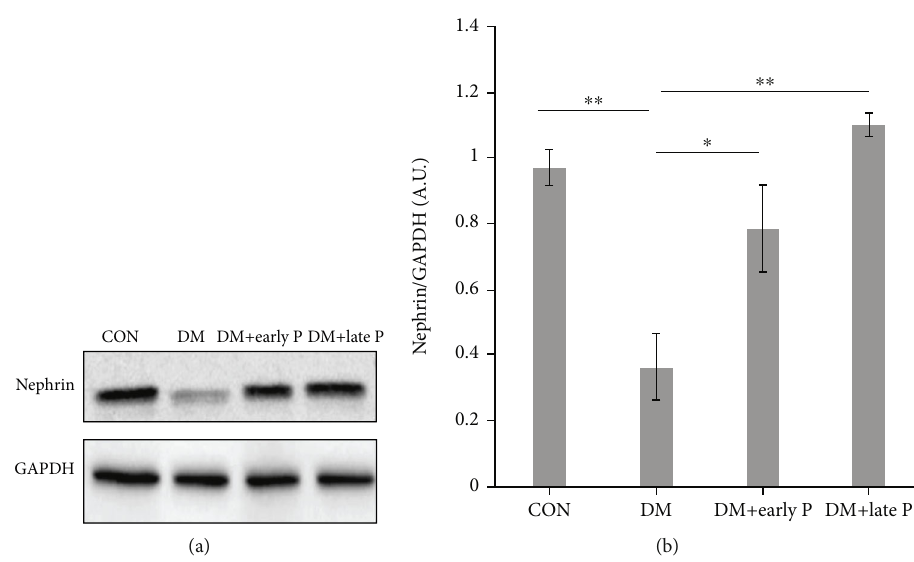
Figure 7: Nephrin levels in mouse renal tissues. (a) Representative western blots of nephrin and GAPDH proteins extracted from mouse renal tissues. (b) Quanti fi cation of total western blots. Renal nephrin levels were signi fi cantly decreased in DM ( n = 11 ) as compared to control mice ( n = 12 ) ( ∗ p < 0 : 01 ). Nephrin levels were restored following early ( n = 12 ) and late ( n = 10 ) paricalcitol treatments as compared to DM mice ( ∗ p < 0 : 05 , ∗∗ p < 0 : 01 , respectively). Error bars correspond to